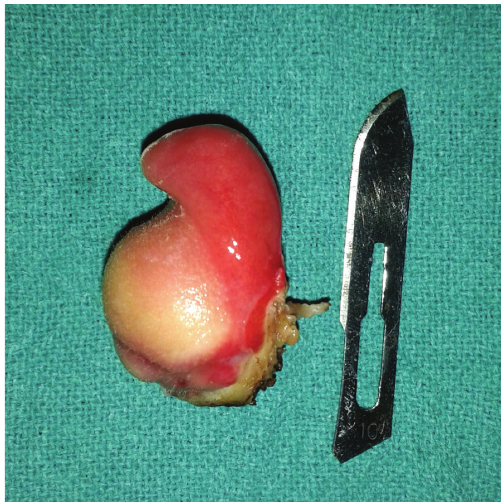
Figure 1: Preoperative photograph showing the mass hanging in the oropharynx.